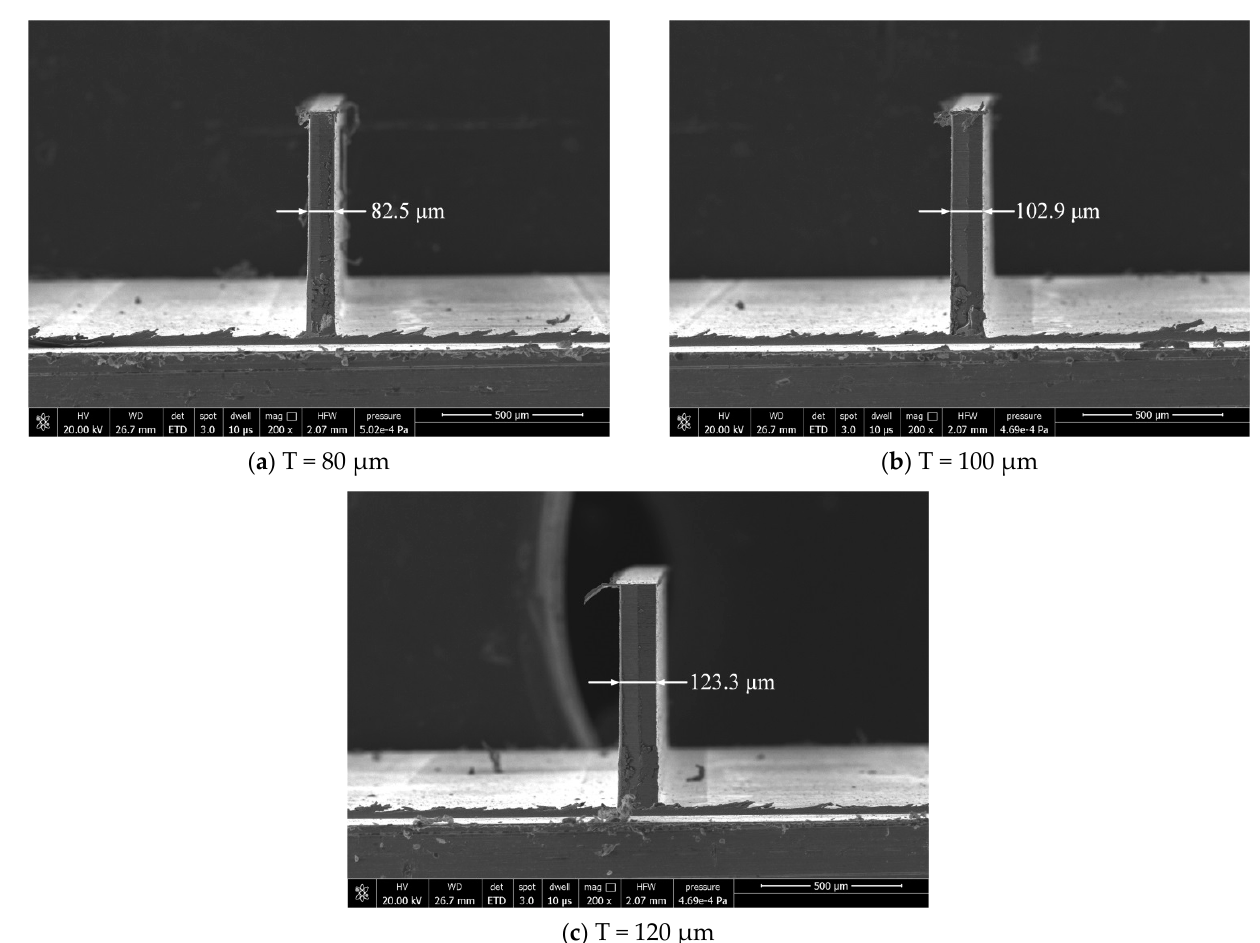
Figure 14. Thin wall measurement results of the first group optimization experiments.